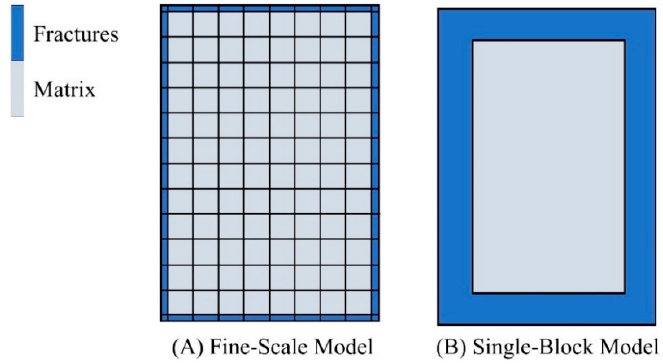
Figure 4. An illustration of the single matrix block model. ( A ) A discretised matrix block (fine-scale model), which can be simulated using a single-porosity model, after Aljuboori et al. [2]. ( B ) Single block model, which can be simulated using the dual-porosity model.